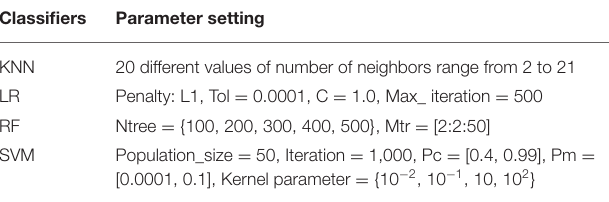
TABLE 2 | The implementation details of the different classifiers.